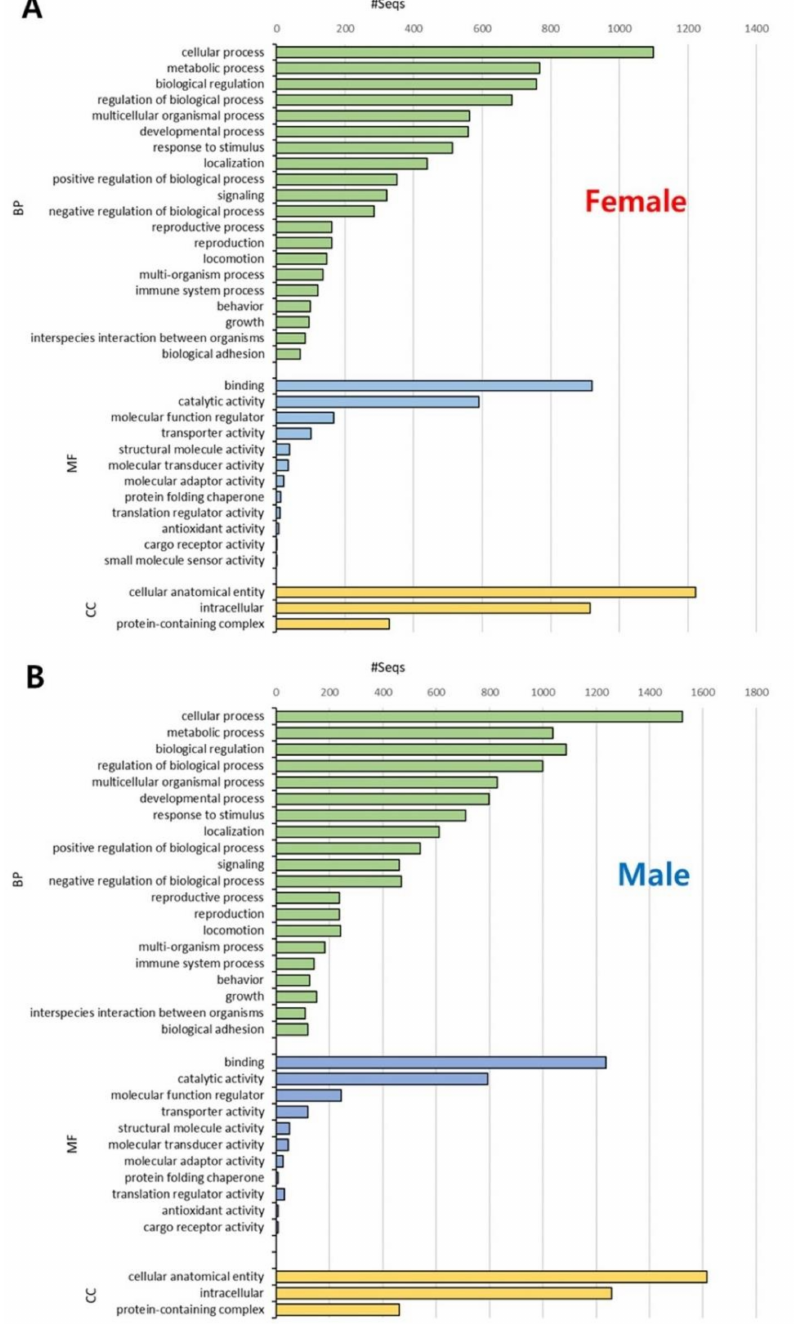
Figure 2. Gene Ontology (GO) distribution of sex-specific transcripts in Artemia franciscana transcrip- tome. Functional annotation was conducted for female-specific transcripts ( A ) and male-specific transcripts ( B ). GO terms were divided into three major categories: biological process (BP, green), molecular function (MF, blue), and cellular component (CC, yellow). The x -axis indicates the number of transcripts, and the y -axis indicates level 2 GO